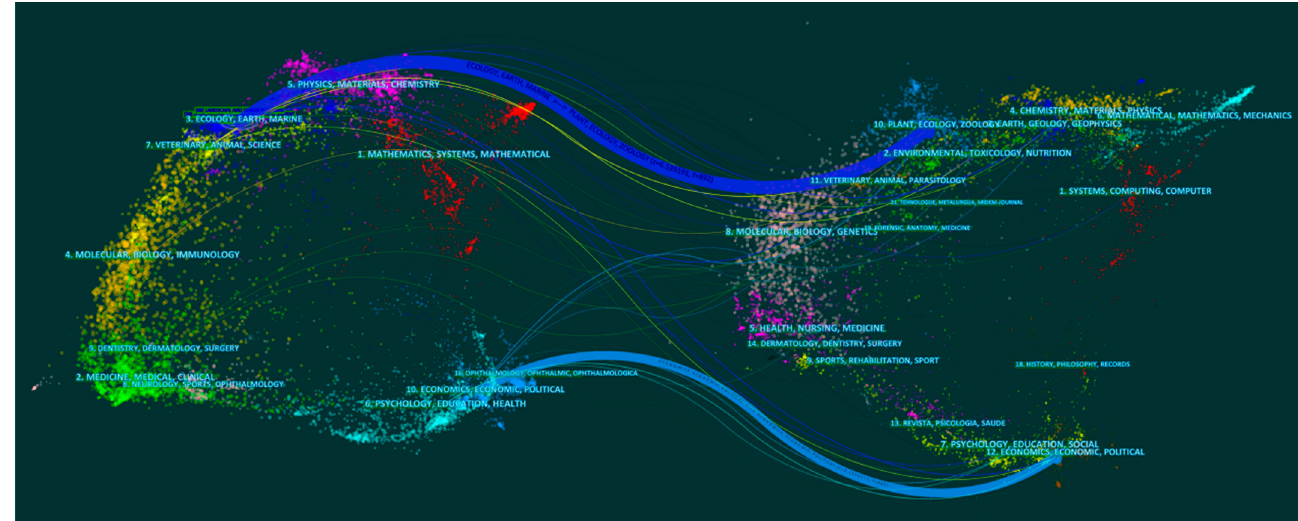
Figure 7. A dual-map overlay showing the correlation between disciplines in RLESs during the period from 1990 to 2005.